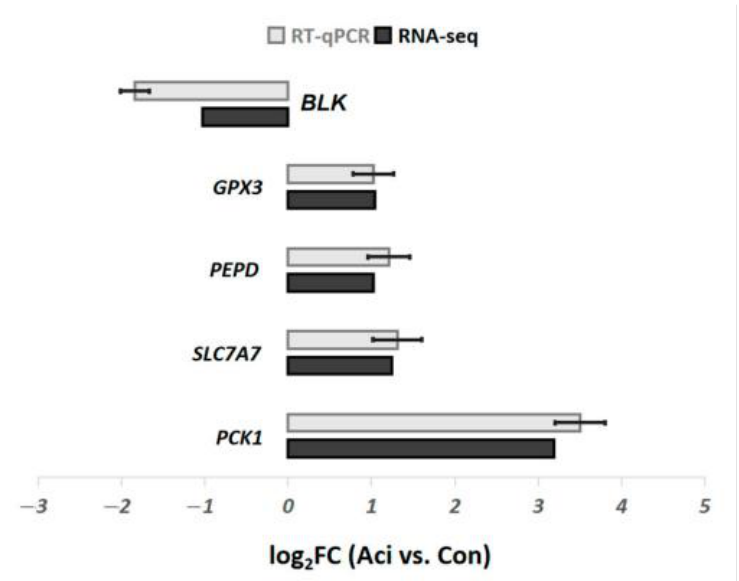
Figure 2. RT-qPCR confirmation of five DEGs identified by